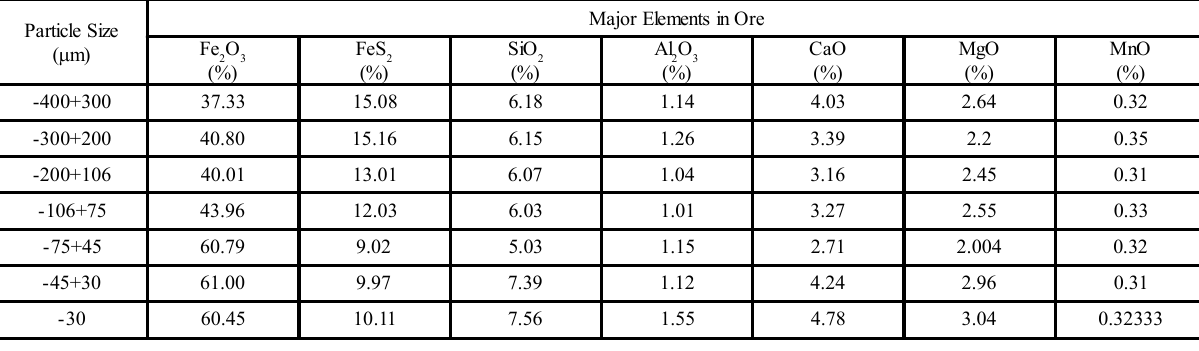
TABLE 1. XRF RESULTS OF VARIOUS PARTICLE SIZES OF ZARD KOH